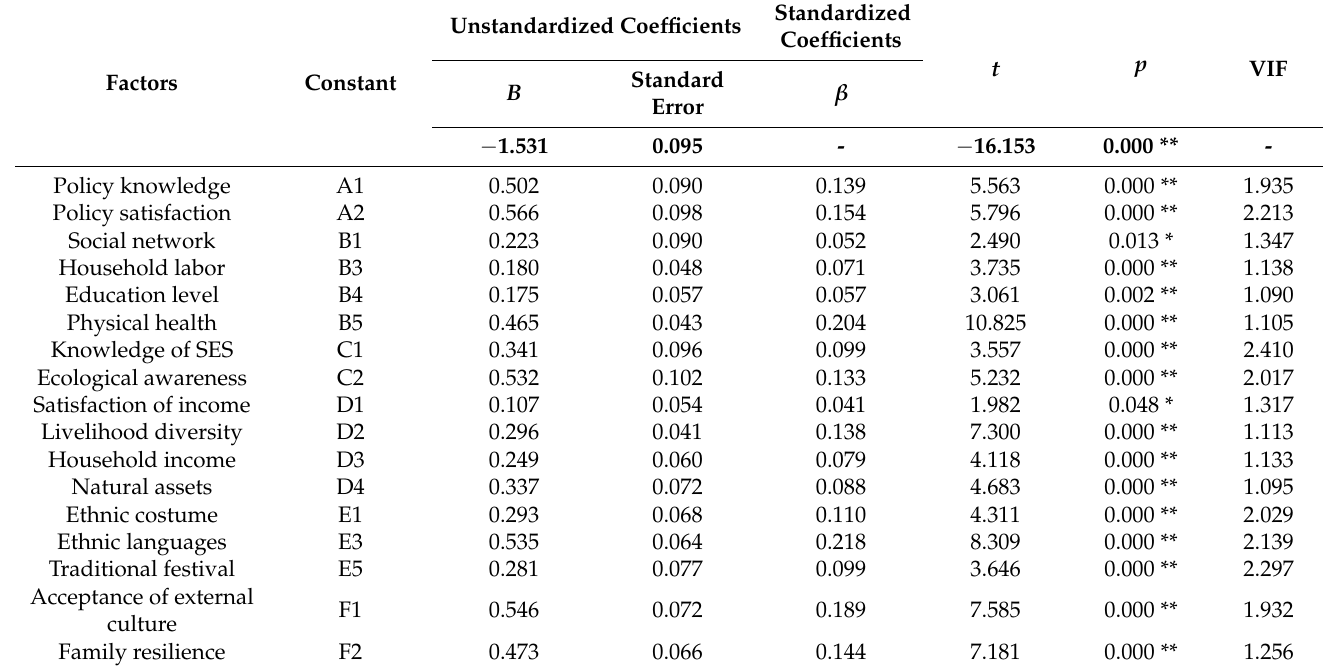
Table 4. Regression analysis results of influencing factors on residents’ adaptability in the